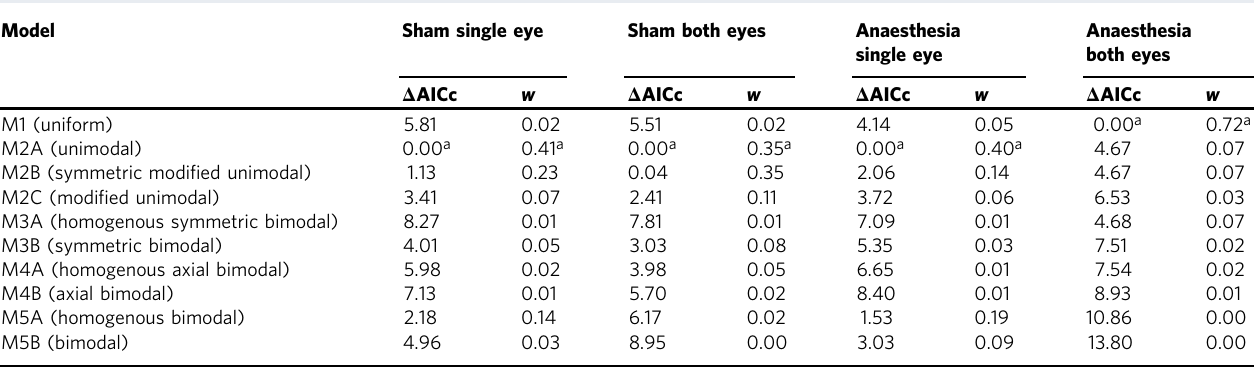
Table 1 Model-based analysis of bat orientation.